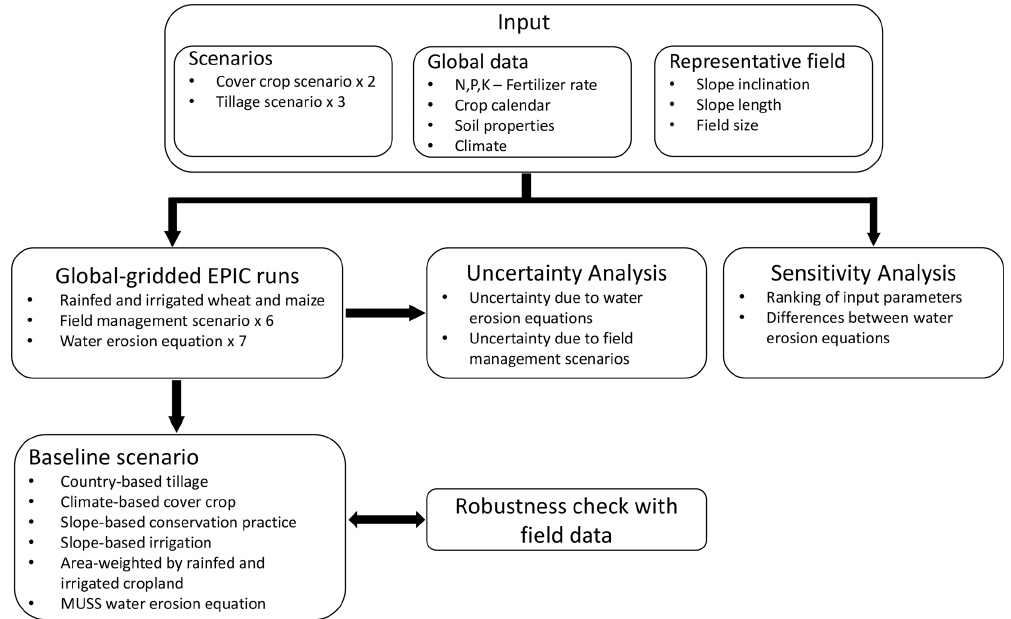
Figure 1. Scheme of the procedure used for simulating global water erosion with EPIC-IIASA and for analysing the uncertainty, sensitivity and robustness of our simulation